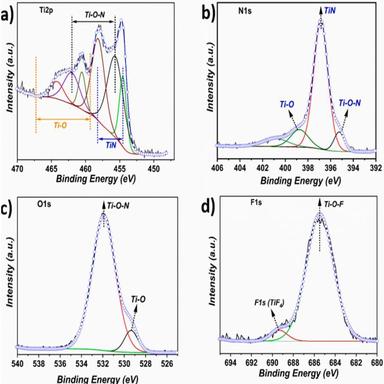
The high-resolution XPS spectra of Ti2NTx MXene: a) Ti2p, b) N1s, c) O1s, and d) F1s.